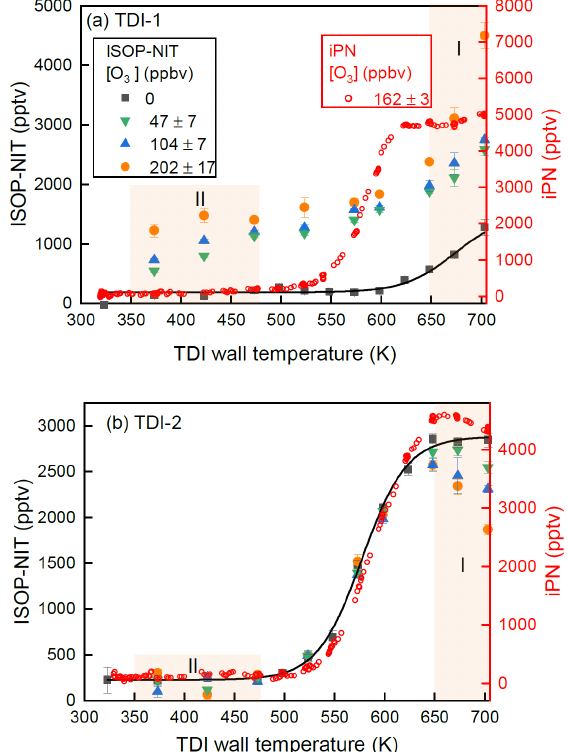
Figure 6. (a) Thermograms of isoprene-derived nitrates gener- ated by mixing N 2 O 5 (as NO 3 source) and ∼ 20ppbv isoprene in SCHARK under dry conditions and sampling via TDI-1. The mixing ratio of O 3 (added only to the inlets) was varied from 0 to 202ppbv. A thermogram of isopropyl nitrate (iPN) in the pres- ence of 162ppbv O 3 (and 3ppbv NO 2 impurity) sampled through the same TDI is shown for comparison. The black solid line is a Boltzmann sigmoidal fit of the ozone-free experiment. The error bars show the standard deviation of the signal (1 σ ). (b) Same as (a) but using